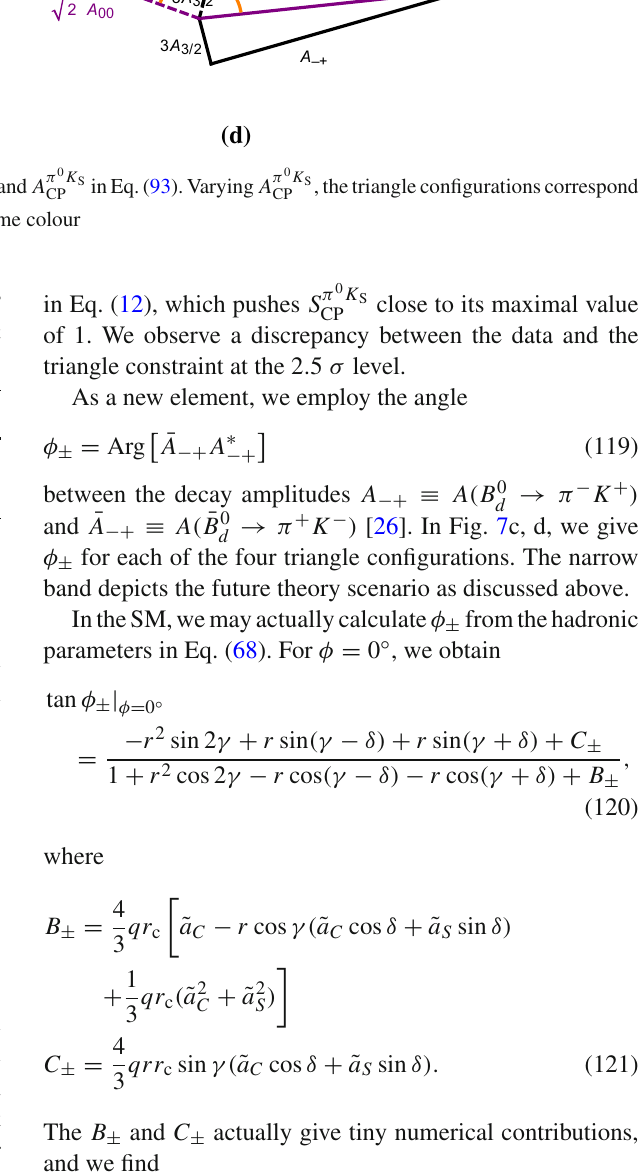
inEq.(93).Varying A π 0 K S ,thetriangleconfigurationscorrespond CP CP